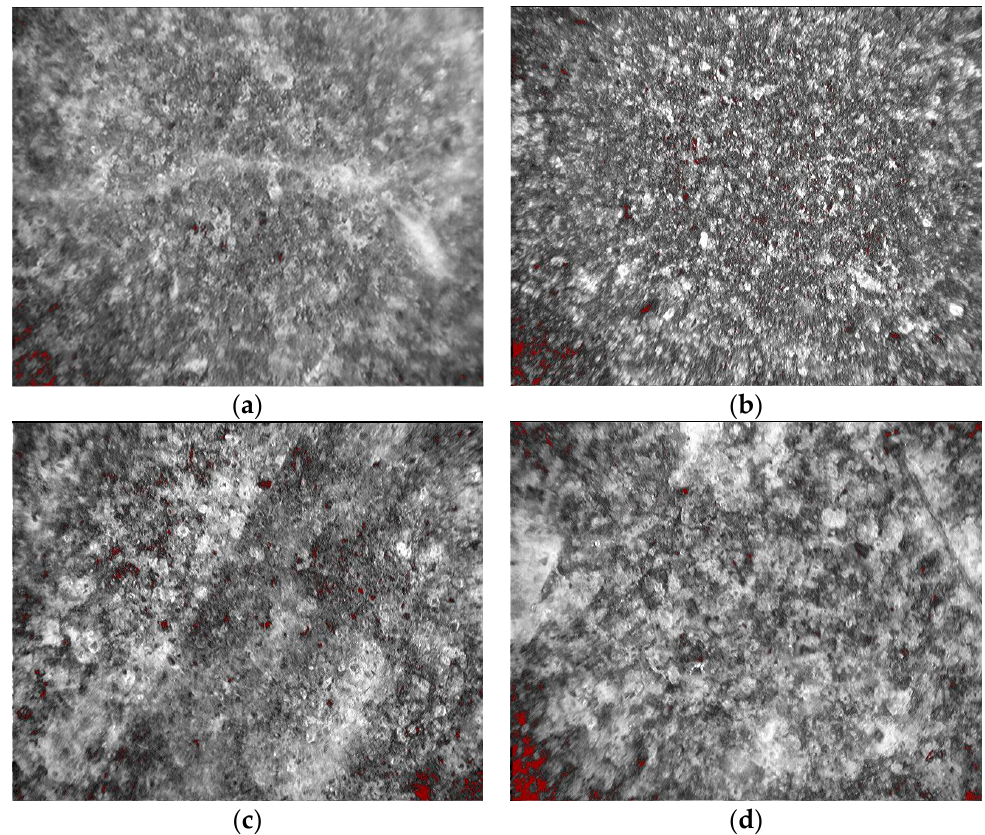
Figure 14. OM images of porosity distribution for different polymer materials. ( a ) OM image of porosity distribution in the control group. ( b ) OM image of porosity distribution with 0.7% PAM. ( c ) OM image of porosity distribution with 0.7% SP. ( d ) OM image of porosity distribution with 0.7% ST.